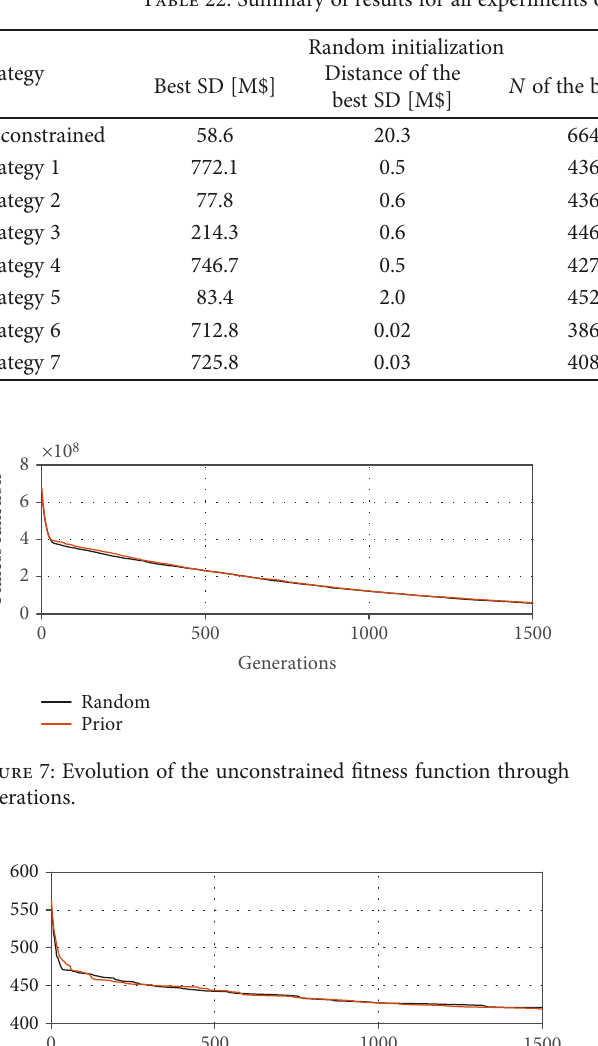
Table 22: Summary of results for all experiments over case study 1: 3-year period G&TEP problem.